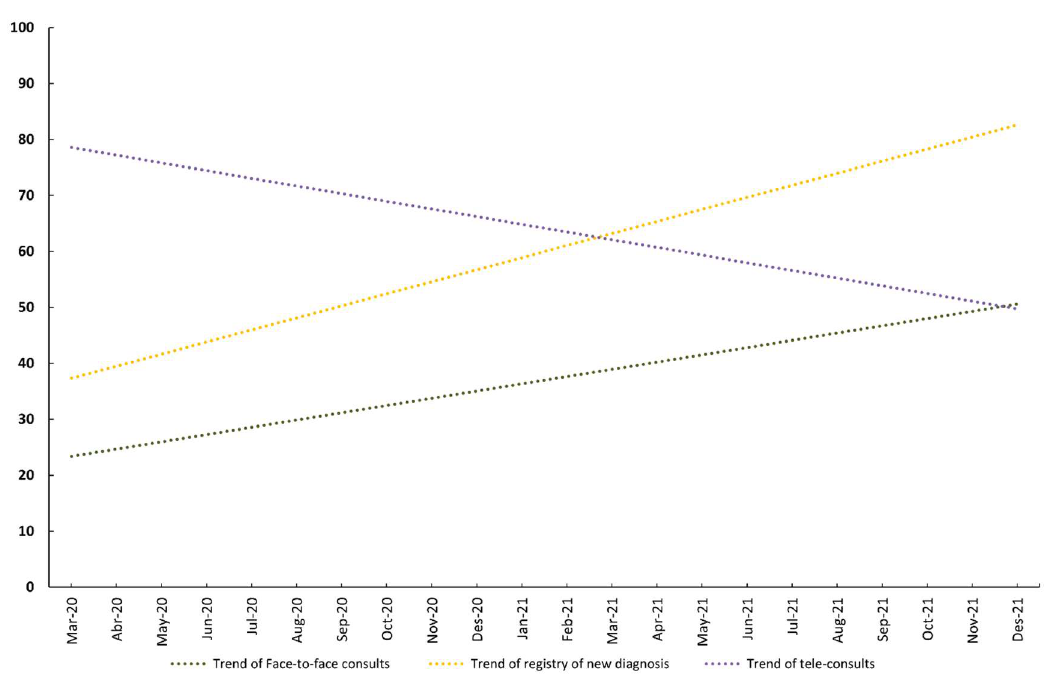
Figure 3. Trends in monthly new diagnoses (excluding COVID-19 cases), tele-consults and face-to- face consults, from January 2020 to December 2021.